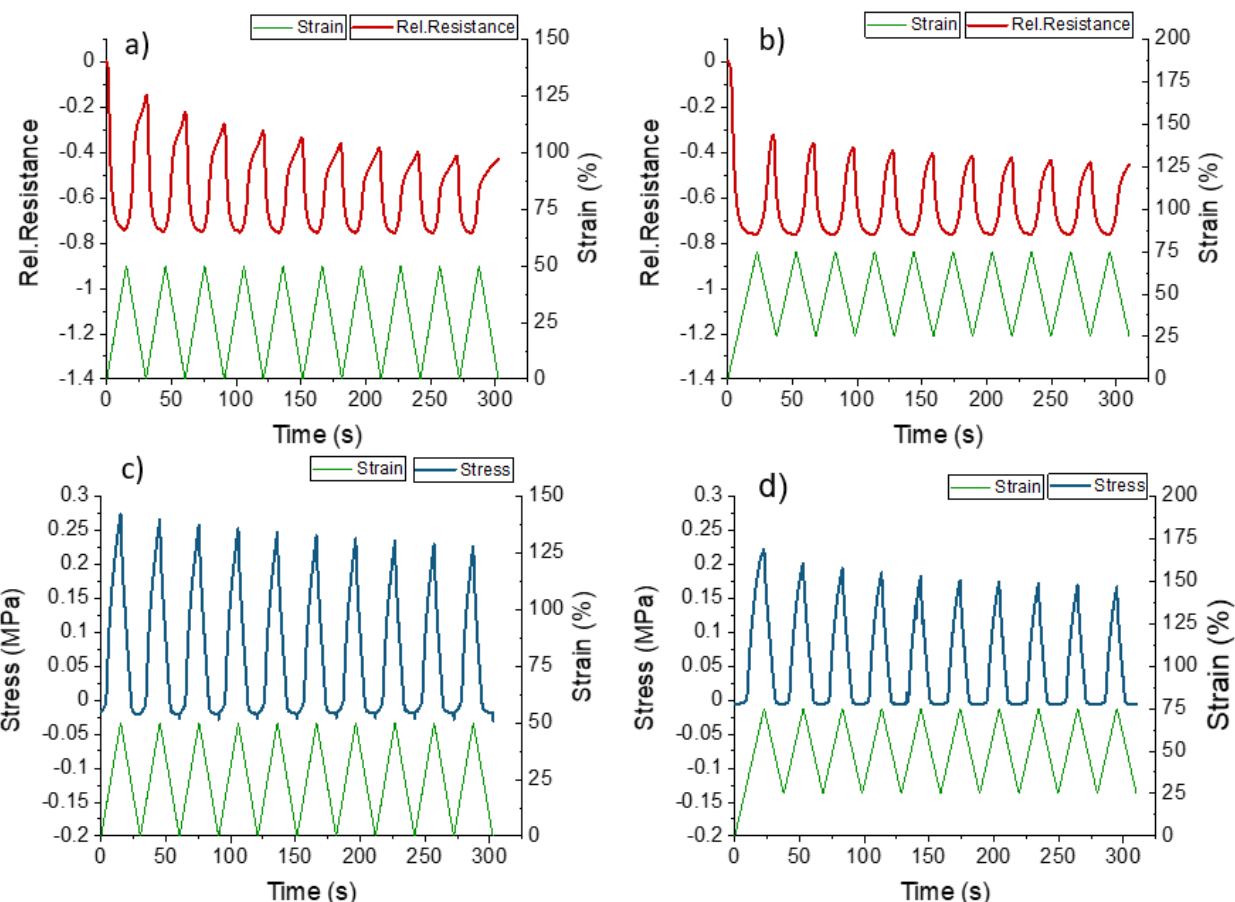
Figure 8. Response of the electrical and mechanical behavior during dynamic tensile testing for ShSFC between the strains 0 and 50% ( a , c ) and 25 and 75% ( b , d ).